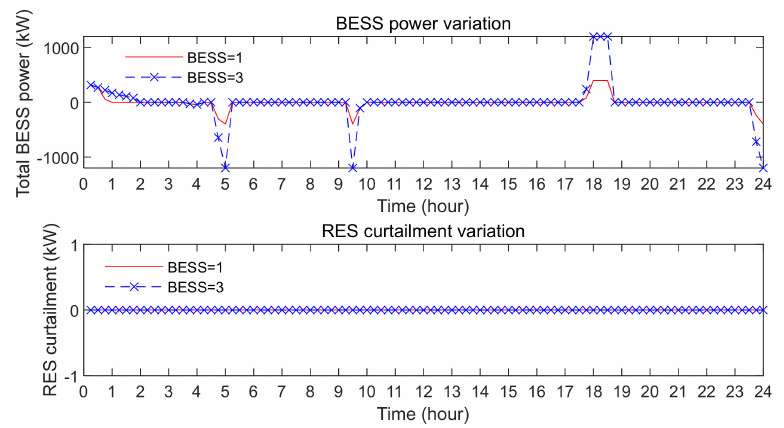
Figure 12. Variations of BESS power and RES curtailment for load type A (the distribution operator is able to sell electricity to the utility grid).